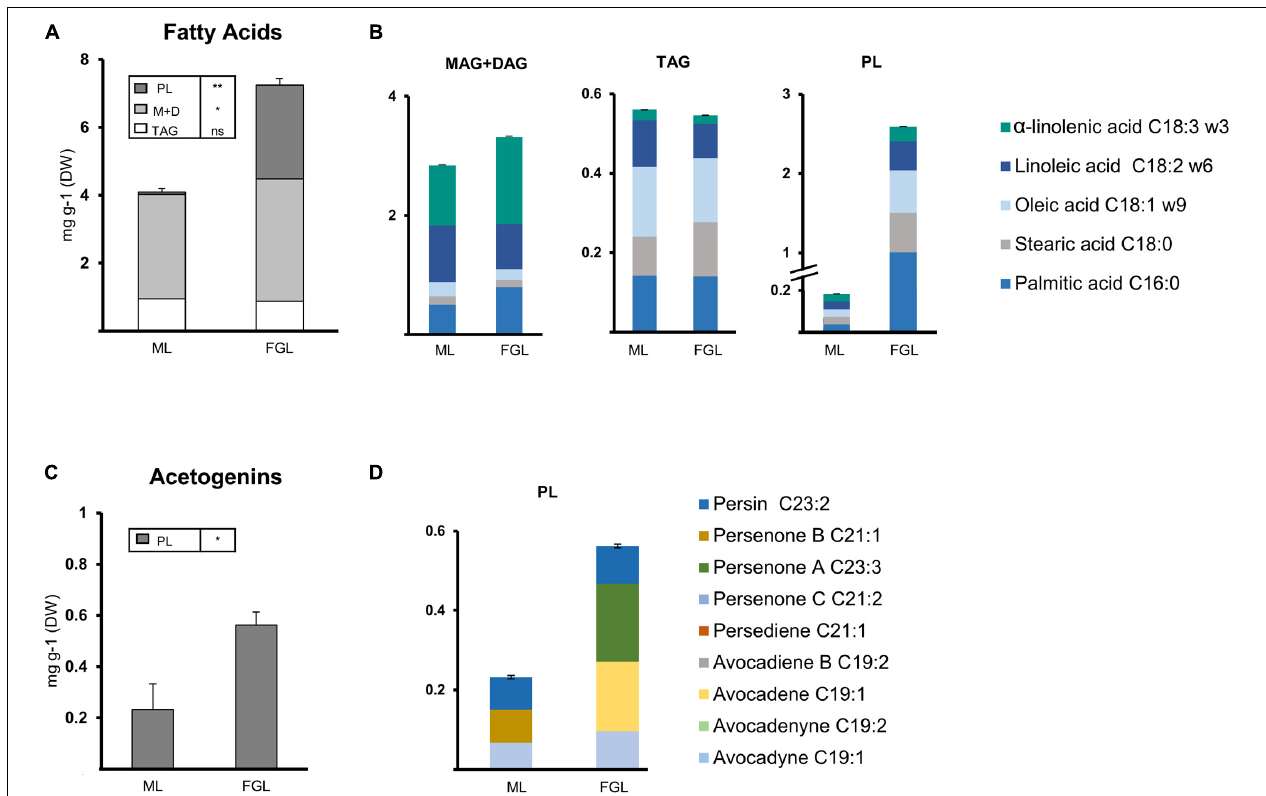
FIGURE 7 | Lipid composition of the leaf extracts from seedlings. (A) Composition of the Fatty acid extracts from ML and FGL. (B) Fatty acid composition of lipid fractions (Left, TAGs; Middle, MAG + DAGs; Right, PLs). (C) Composition of the Acetogenin extracts from ML and FGL. (D) Acetogenin composition of lipid fractions. Bars represent an average of 3 samples. (ANOVA, Fisher LSD, * P < 0.05, ** P < 0.01; ns = non-significant). Error bars indicate Standard Error (SE). PL, polar lipids; MAG, monoacylglycerol; DAG, diacylglycerol; TAG, triacylglycerol. N =